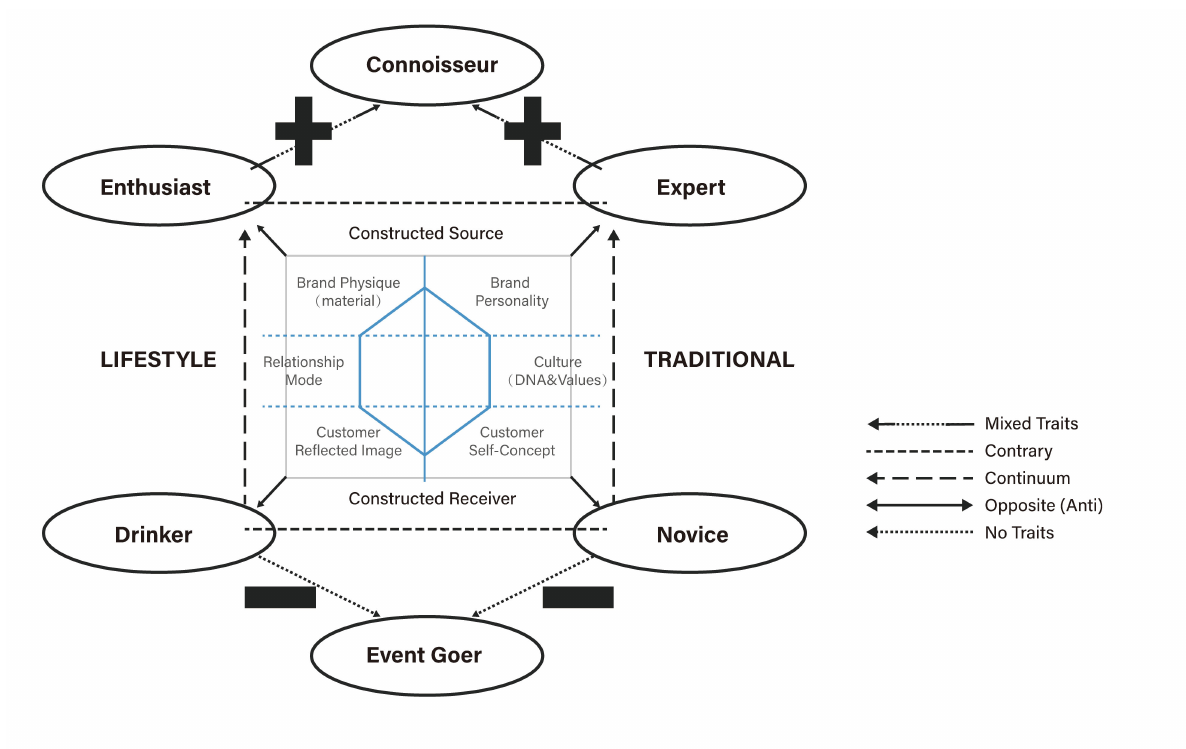
Figure 3. Semiotic Square and Identity Prism model for Fine